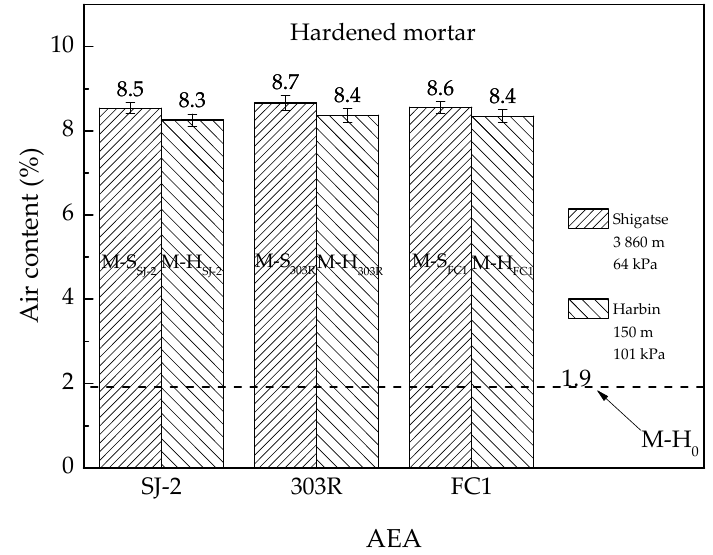
ff erent atmospheric